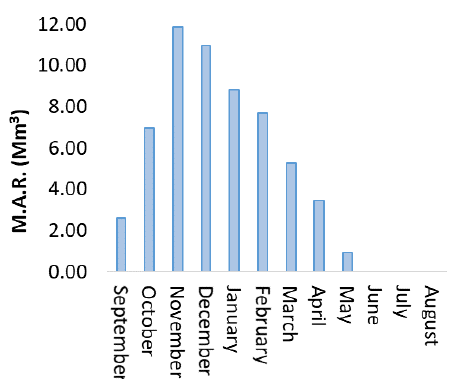
Figure 14. Monthly average recharge (M.A.R.) of Capodacqua di Spigno basin.